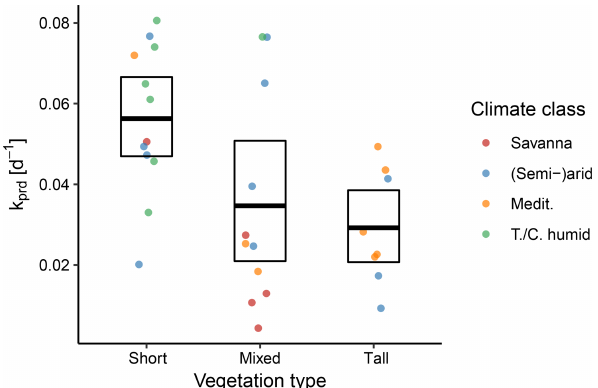
Figure 10. Between-site distributions of the predicted decay rate k stratified according to the aggregated vegetation and climate classes. The points represent individual sites, the bold line denotes the mean across sites, and the box represents the bootstrapped 95% confidence interval.